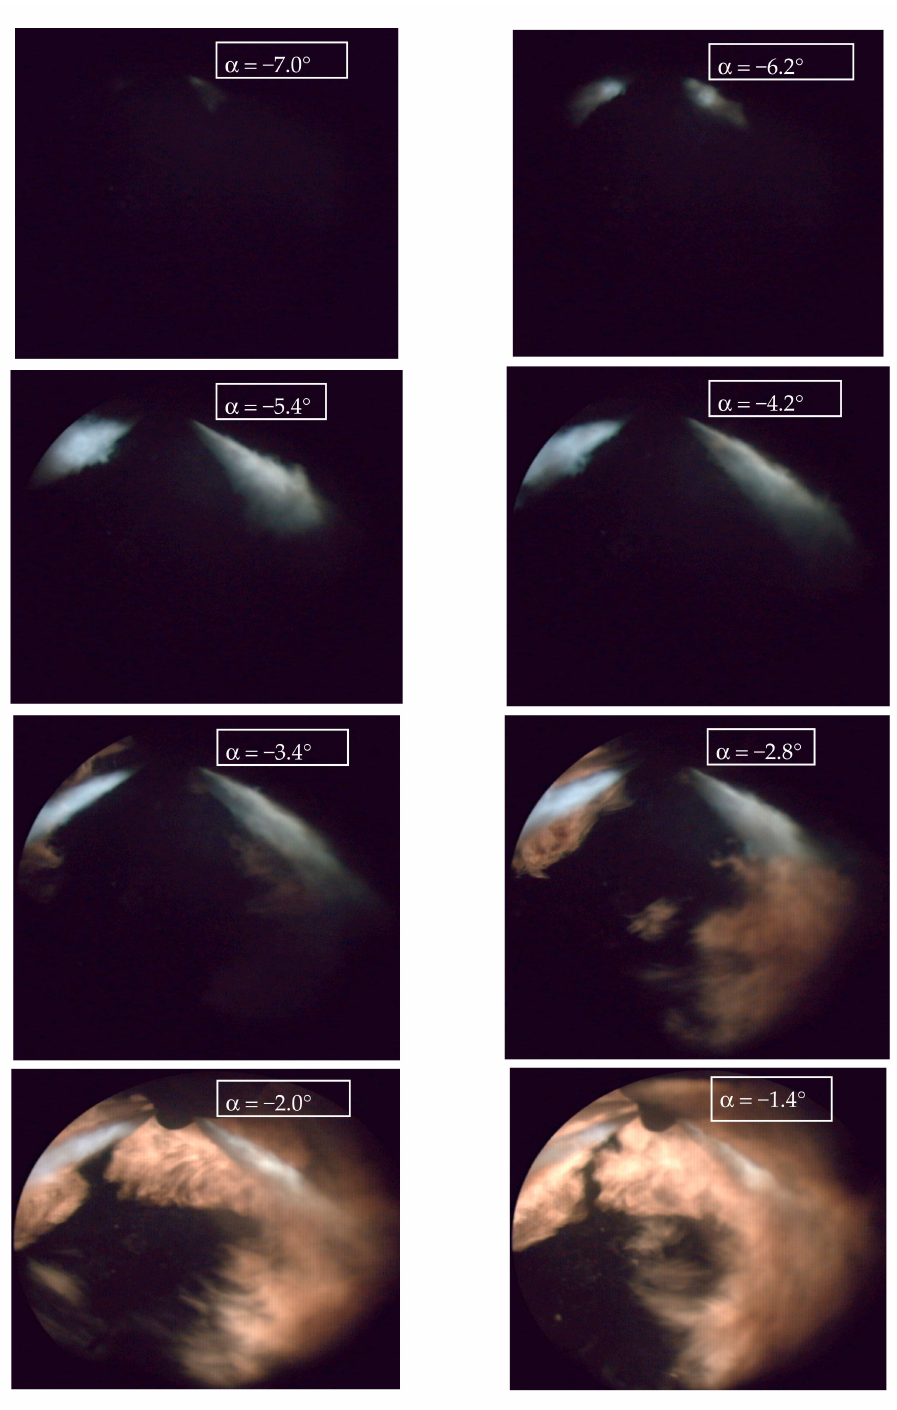
Figure 6. Example recording of injection and combustion processes in diesel engine cylinder for selected crankshaft angles of rotation (original footage, colour, registration every 0.1 ◦ CA, selected from recorded